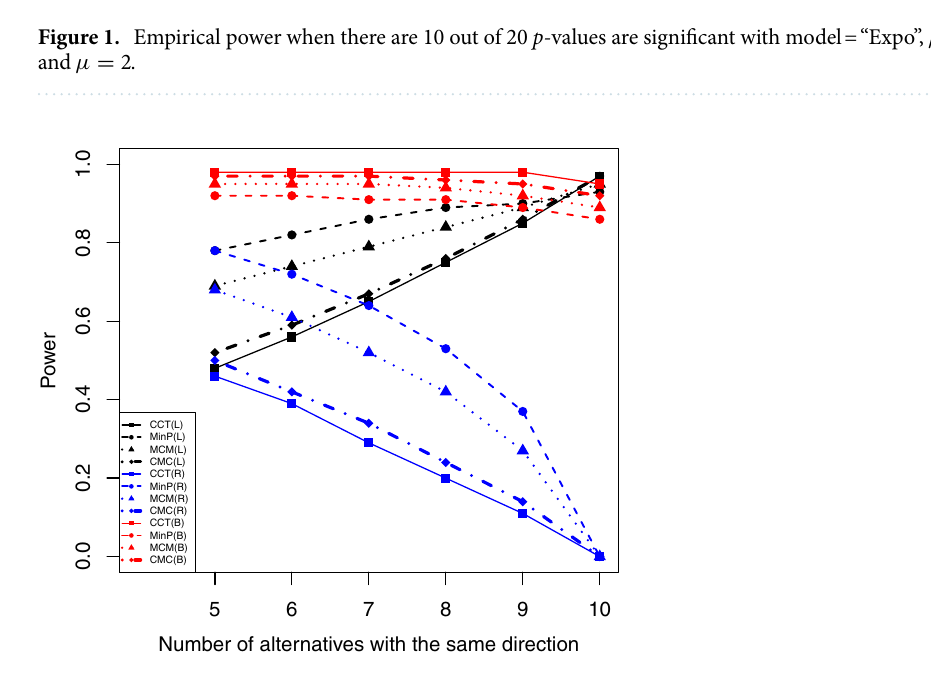
Figure 2. Empirical power when there are 10 out of 20 p -values are significant with model = “Poly”, r = 1.5 , and µ = 2